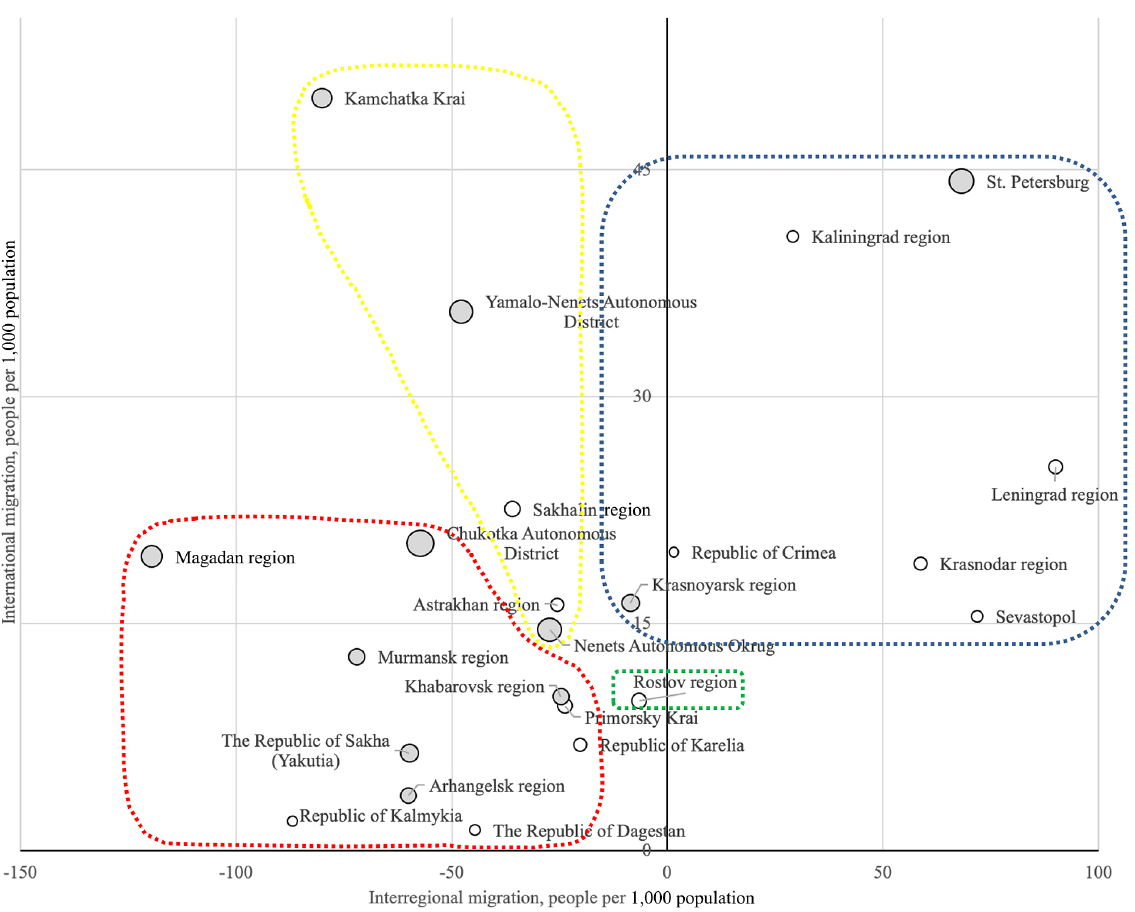
Fig. 3. The ratio of the final index of innovative performance and indicators of interregional and international migration in 2011–2018.